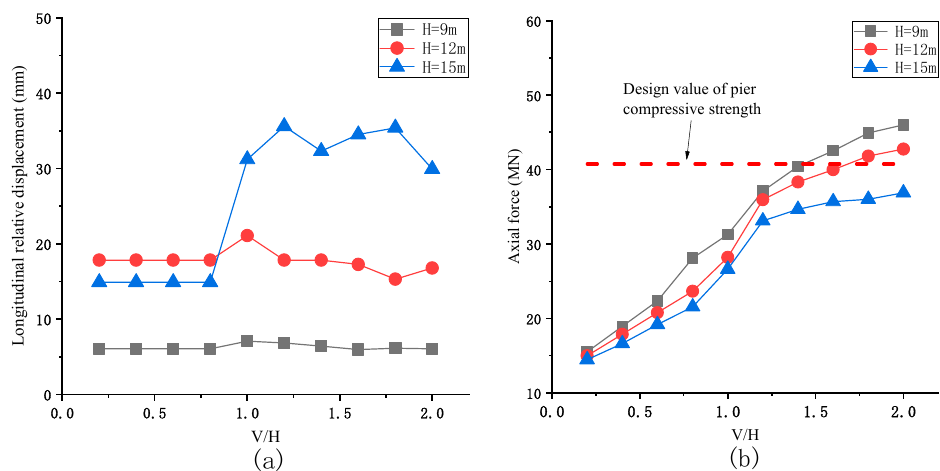
Figure 12. Seismic response of bridges under different vertical seismic excitation amplitudes: ( a ) Longitudinal relative displacement of main girder and pier under different vertical seismic excitation amplitudes; ( b ) Vertical contact force between main girder and pier under different vertical seismic excitation amplitudes.